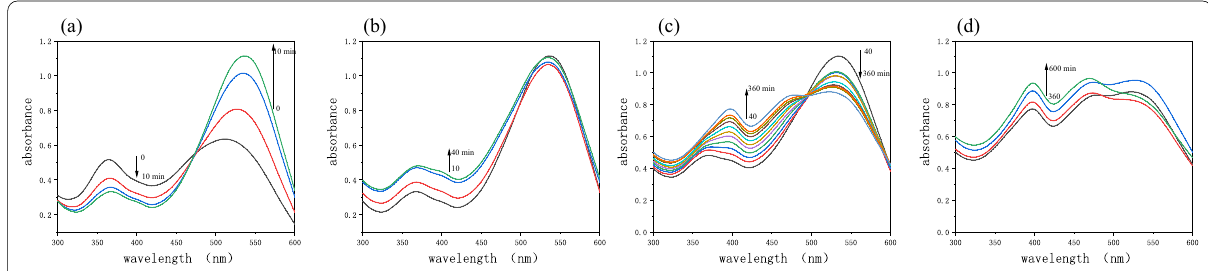
Fig. 7 Time-dependent absorption spectra of probe BCD (60 µM) at different time scales upon addition of Cys (1 mM) in DMF-Hepes buffer (8/2, v/v, pH 7.4) =